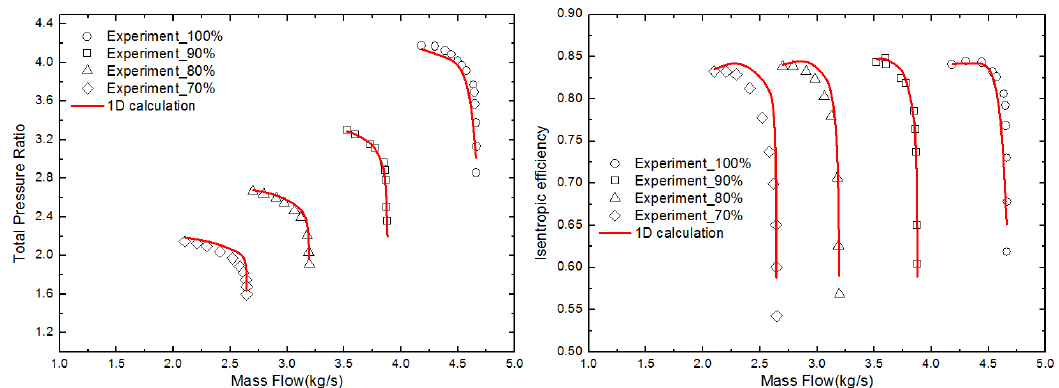
Figure 2. Performance prediction of HPCC impeller with a vaned diffuser.